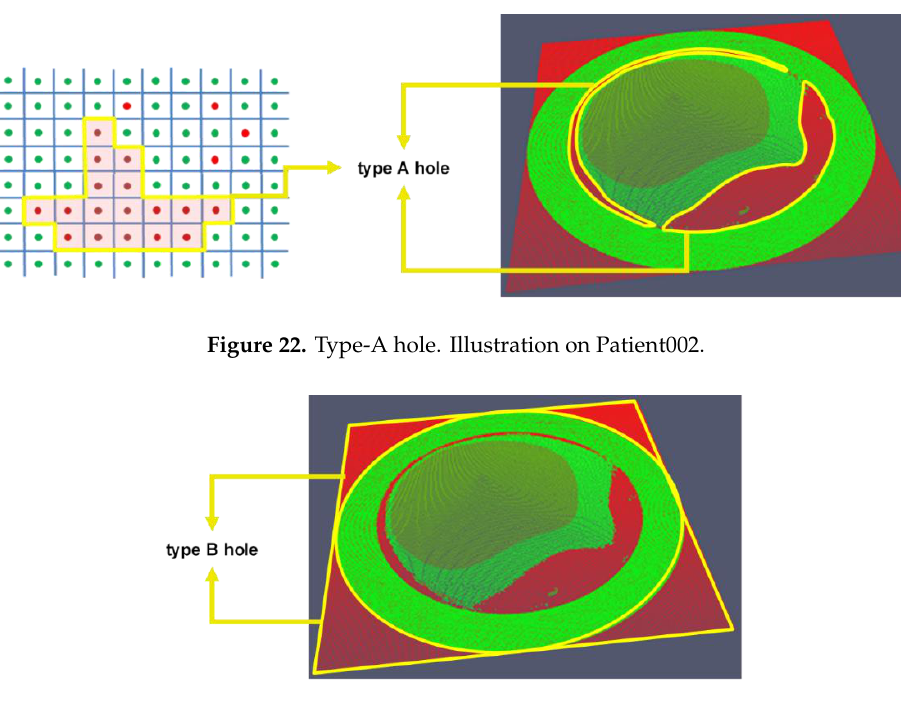
Figure 23. Type-B hole. Illustration on Patient 002.